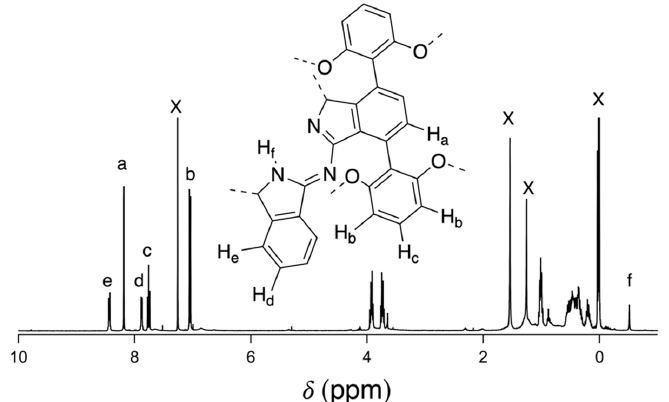
Figure 3. 1 H-NMR spectrum of 2 in CDCl 3 . The signals for residue solvents and the internal standard TMS are denoted as X.